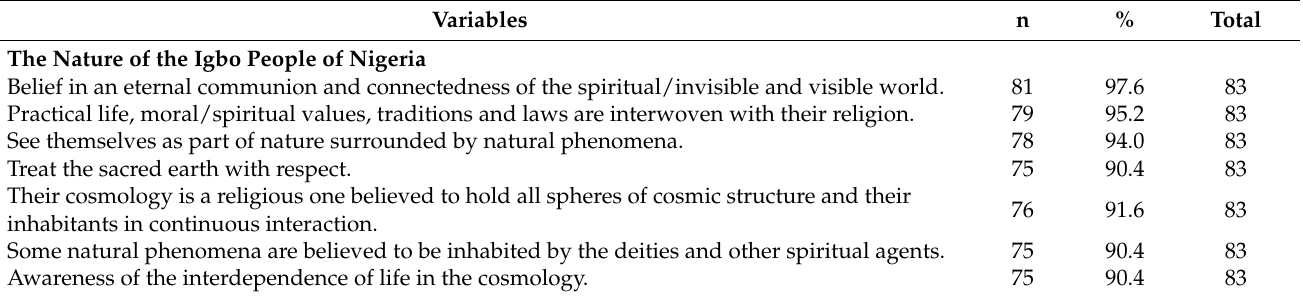
Table 1. The Nature of the Igbo People of Nigeria. Variables n %